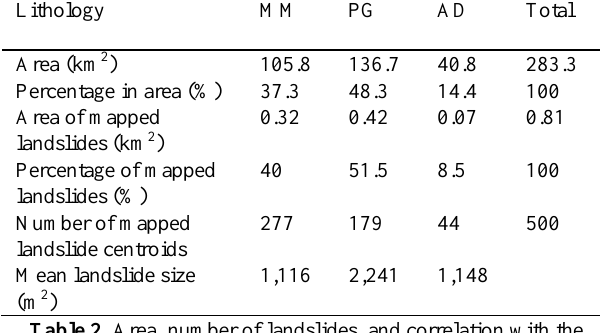
Table 2. Area, number of landslides, and correlation with the geological context of Brusque city. MM: Metapelite and metapsammite; PG: Porphyritic granitoids; AD: Alluvial deposits.